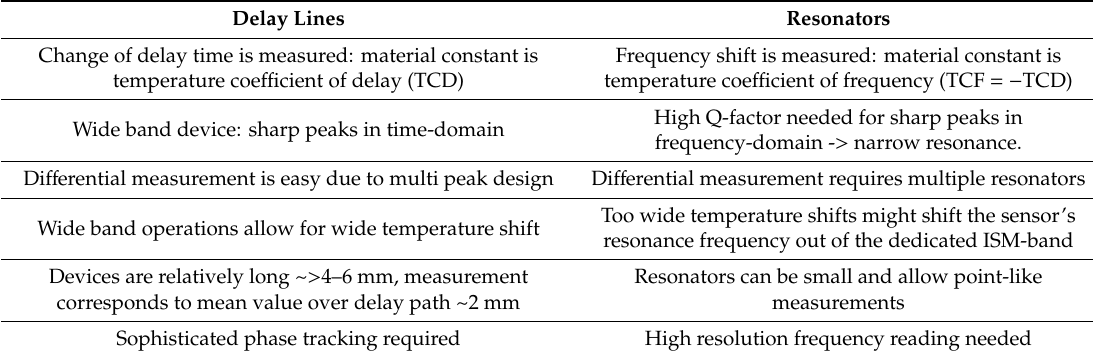
Table 1. Comparison of delay line and resonator SAW